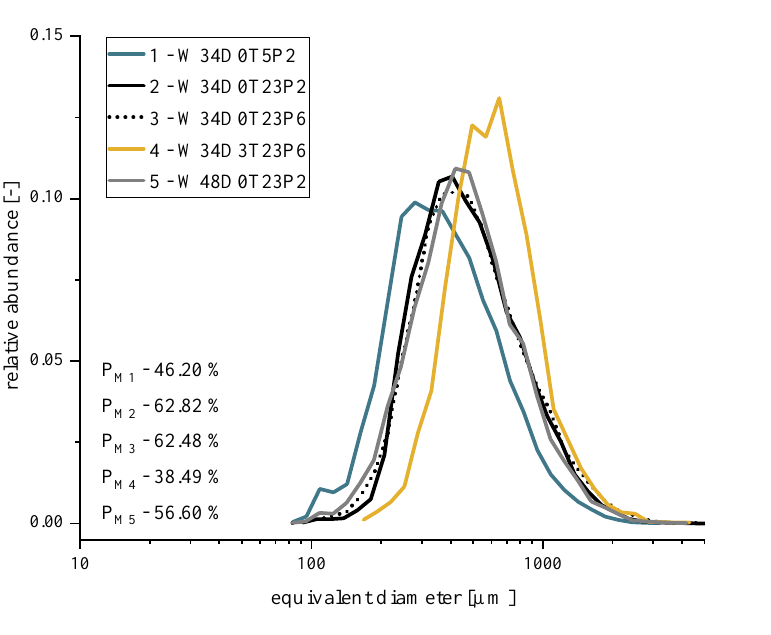
Figure 1. Pore size distribution of macroscopic pores (via X-ray).